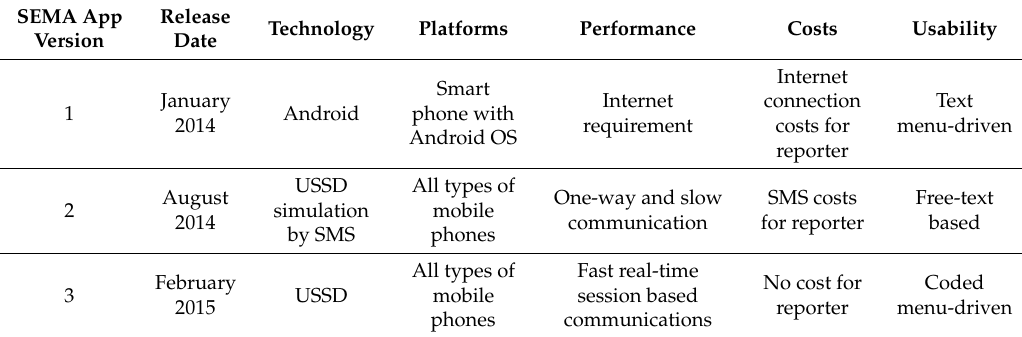
Table 2. SEMA Mobile App versions and